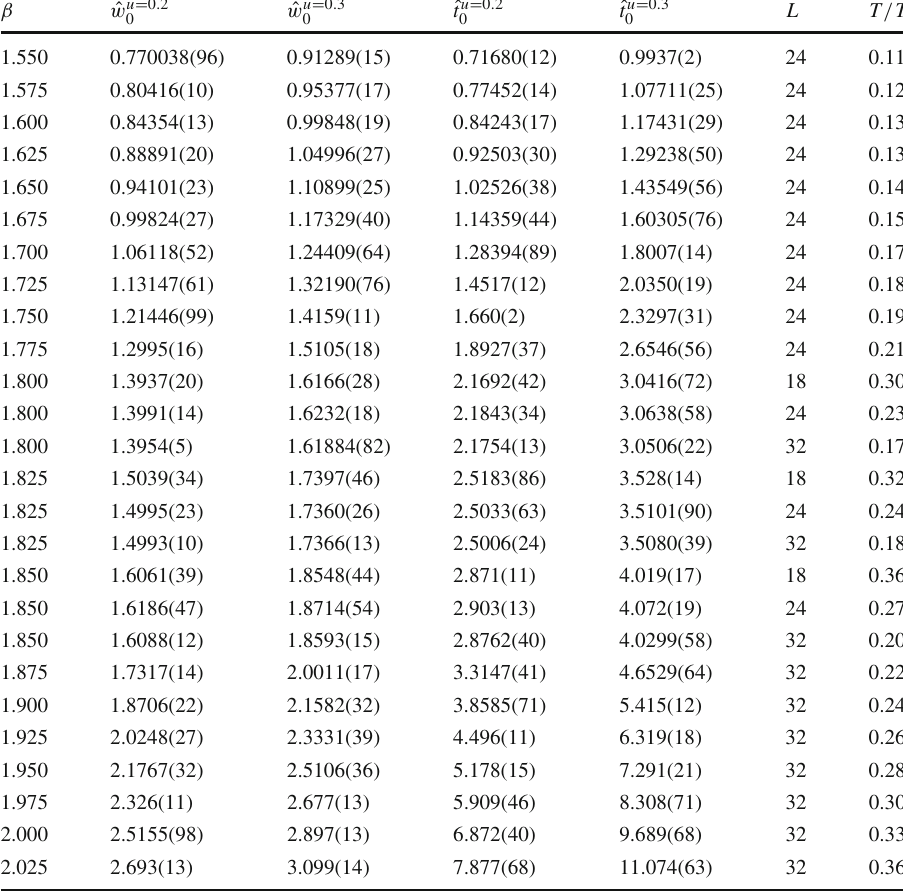
Table 3 Summary of the values of ˆ w 0 and ˆ t 0 used to determine the β -function. The quoted error is only statistical and does not include systematic errors arising from different choices of the fit of the flow. ˆ L is the size of the